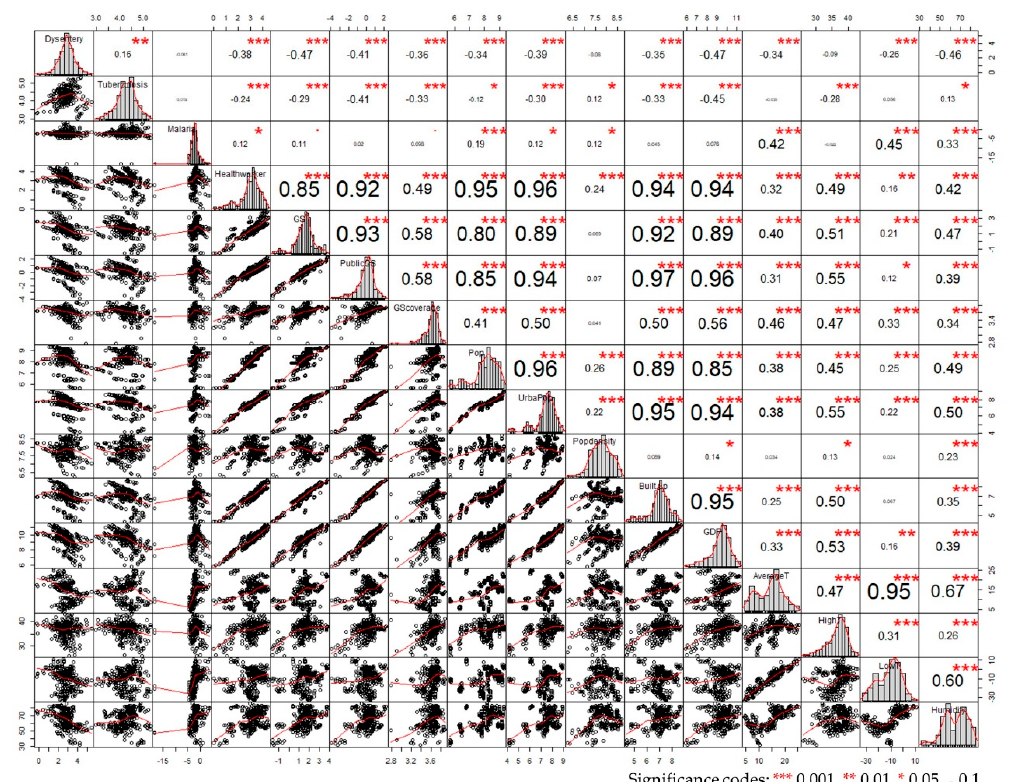
Figure 7. Correlation analysis of all variables by R. Note: The distribution of each variable is shown on the diagonal, the bivariate scatter plots with a fitted line are on the left side of the diagonal, and the values of the correlation plus the significance level as stars are on the right side. Table 6. Results of PDM of